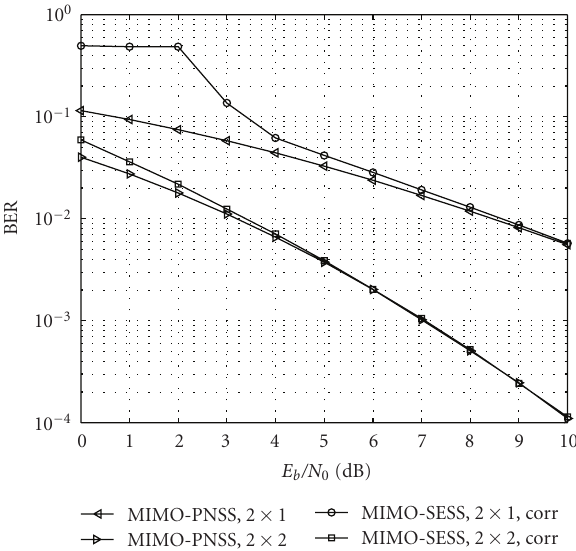
Figure 4: Comparison between an MIMO-PNSS system and the proposed MIMO-SESS system without iterative detection, two transmit antennas using full-rate code G 2 , N =